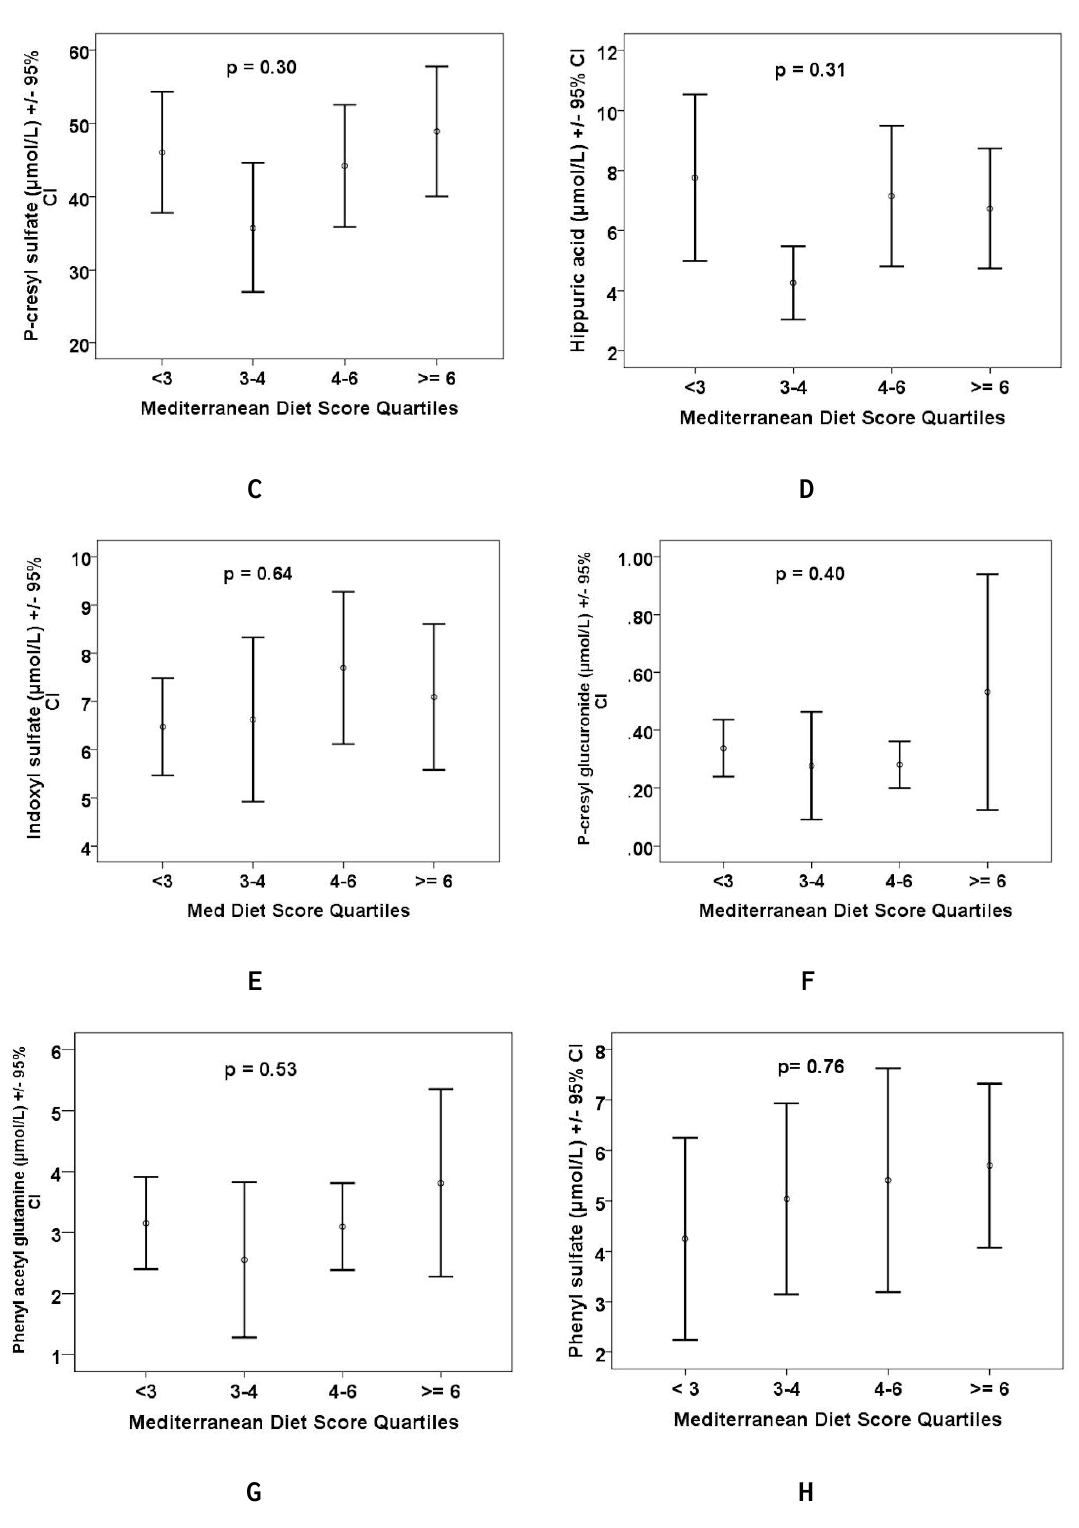
Figure 3. Carotid plaque burden and levels of intestinal metabolites by quartile of the Mediterranean diet score. Neither carotid plaque burden, nor the plasma levels of any of the metabolites, were significantly different by quartiles of the Mediterranean diet score. ( A ) Total plaque area (mm 2 ); ( B ) trimethylamine N-oxide; ( C ) p-cresyl sulfate; ( D ) hippuric acid; ( E ) indoxyl sulfate; ( F ) p-cresyl glucuronide; ( G ) phenyl acetyl glutamine; and ( H ) phenyl sulfate.